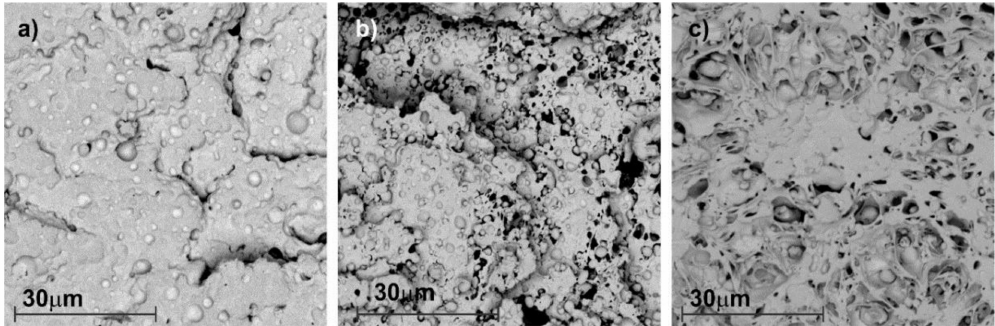
Figure 1. SEM Images at 3500 × magnification of the samples. ( a ) PP-15PHB; ( b ) PP-15PLA; ( c ) PP-15TPS.